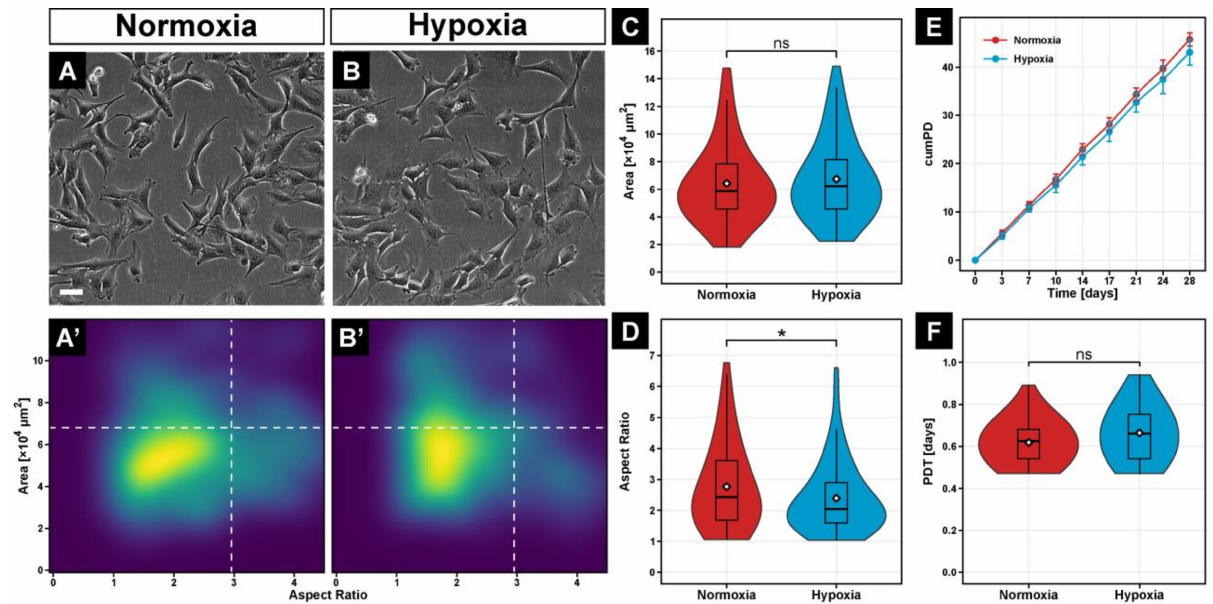
Figure 1. Phase-contrast images of C2C12 cells grown continuously for 28 days at 21% O 2 ( A ) or 2% O 2 ( B ). Quantification of cell area and aspect ratio illustrates the morphology distribution between normoxic ( A’ ) and hypoxic ( B’ ) cultured cells. Statistical analysis of individual cell morphology parameters revealed a significant decrease in aspect ratio ( D ) but not area ( C ). The effect of long- term hypoxia on cell proliferation, evaluated by cumulative population doublings (cumPD) ( E ) and population doubling time (PDT) ( F ) over a period of 28 days showed no significant differences between the two oxygen levels. Box plots represent the median, quartiles, range, and mean (white